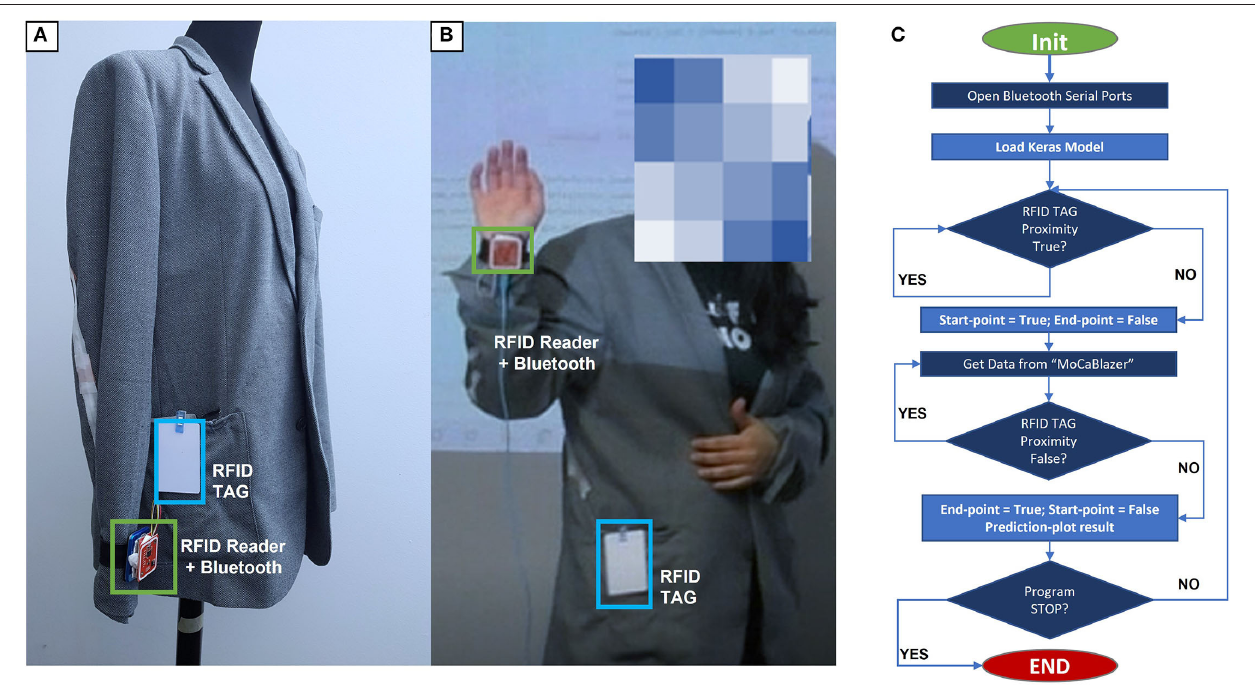
FIGURE 6 | Real-time recognition system. (A) “MoCaBlazer” with the RFID Reader-tag pair positions. (B) Volunteer wearing the “MoCaBlazer” with the RFID synchronization system. (C) Flow-diagram of the real-time recognition python script.